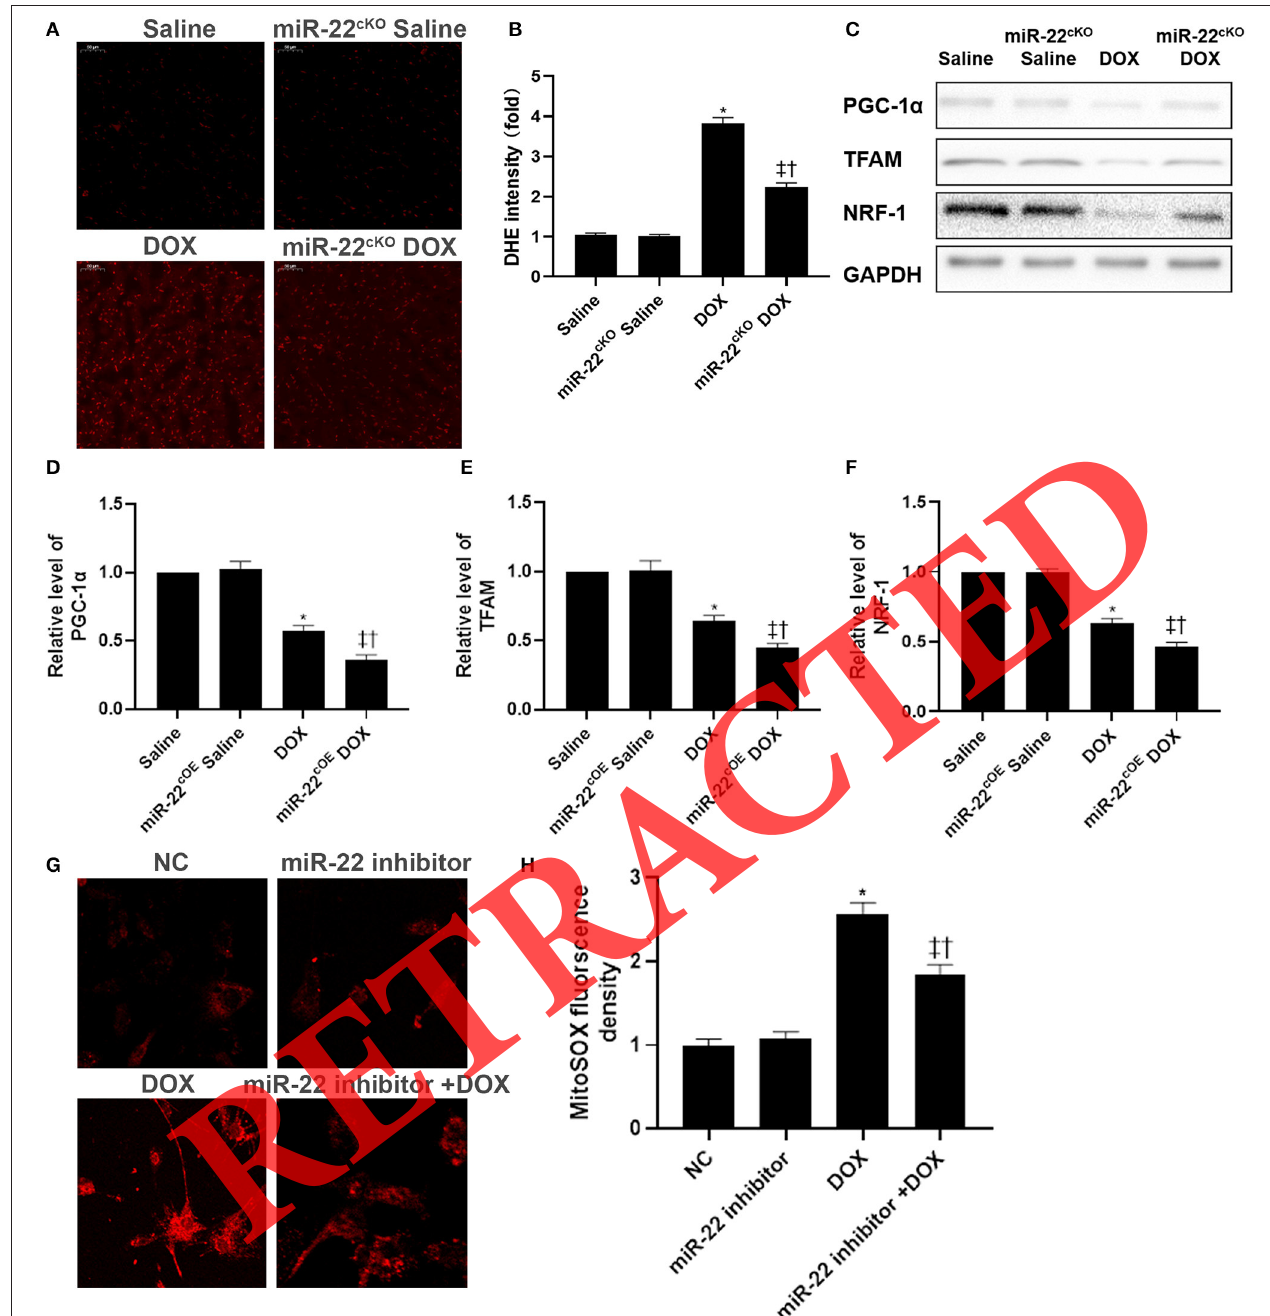
FIGURE 2 | Knocking out miR-22 mitigates mitochondrial dysfunction in DOXIC. (A,B) Representative images of DHE staining, (C) Representative images of blots, (D) Relative PGC-1 α protein level ratio, (E) Relative TFAM protein level ratio, (F) Relative NRF-1 protein level ratio, Data were expressed as mean ± SEM. * P < 0.05 vs. saline group, ‡ P < 0.05 vs. DOX group, † P < 0.05 vs. miR-22 cKO group. (G,H) Representative images of mitochondrial ROS in neonatal mice cardiomyocytes, Scale bars = 50 µ m. * P < 0.05 vs. NC group, ‡ P < 0.05 vs. NC + DOX group, † P < 0.05 vs. miR-22 inhibitor